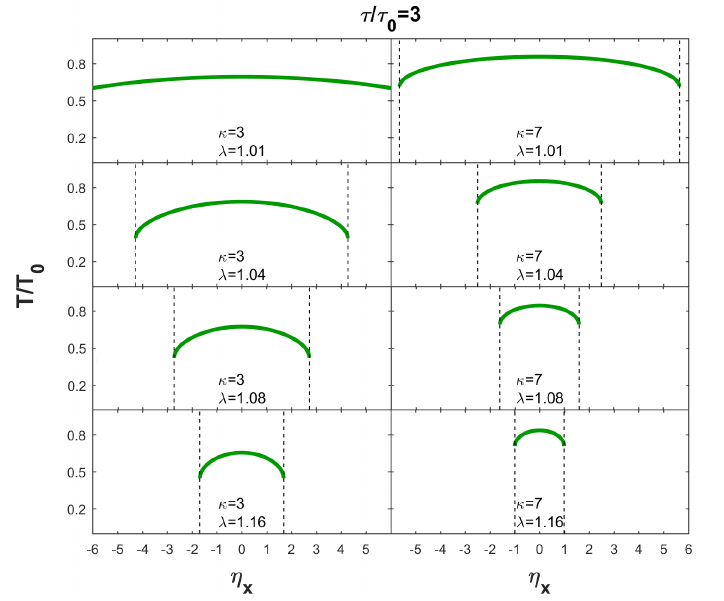
Figure 2. Space-time rapidity η x dependence of the temperature profile at a fixed τ / τ 0 = 3 fm/c, from our new, longitudinally finite solutions of relativistic hydrodynamics. These plots highlight the finiteness of these solutions, with parameters the same as for Figure 1: κ = ε / p = 3 in the left column, κ = 7 in the right column, evaluated for the acceleration parameters λ = 1.01, 1.04, 1.08 and 1.16 (from top to bottom rows) corresponding to nearly flat and with increasing λ , gradually narrowing rapidity